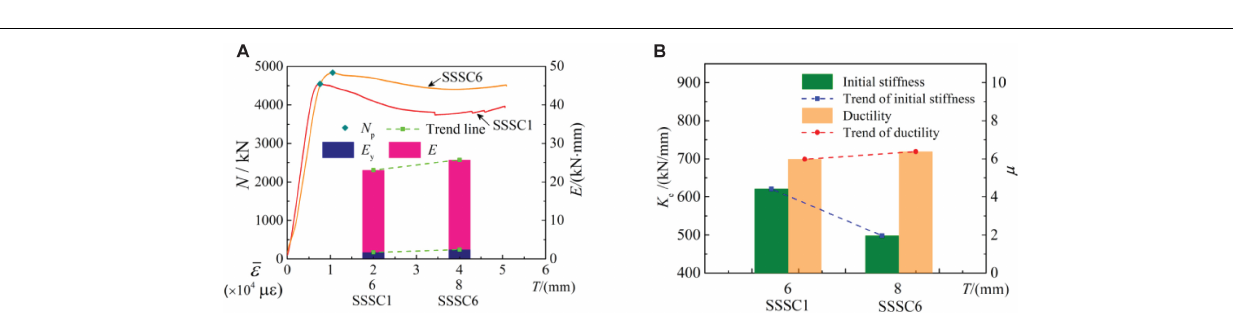
Frontiers in Materials |